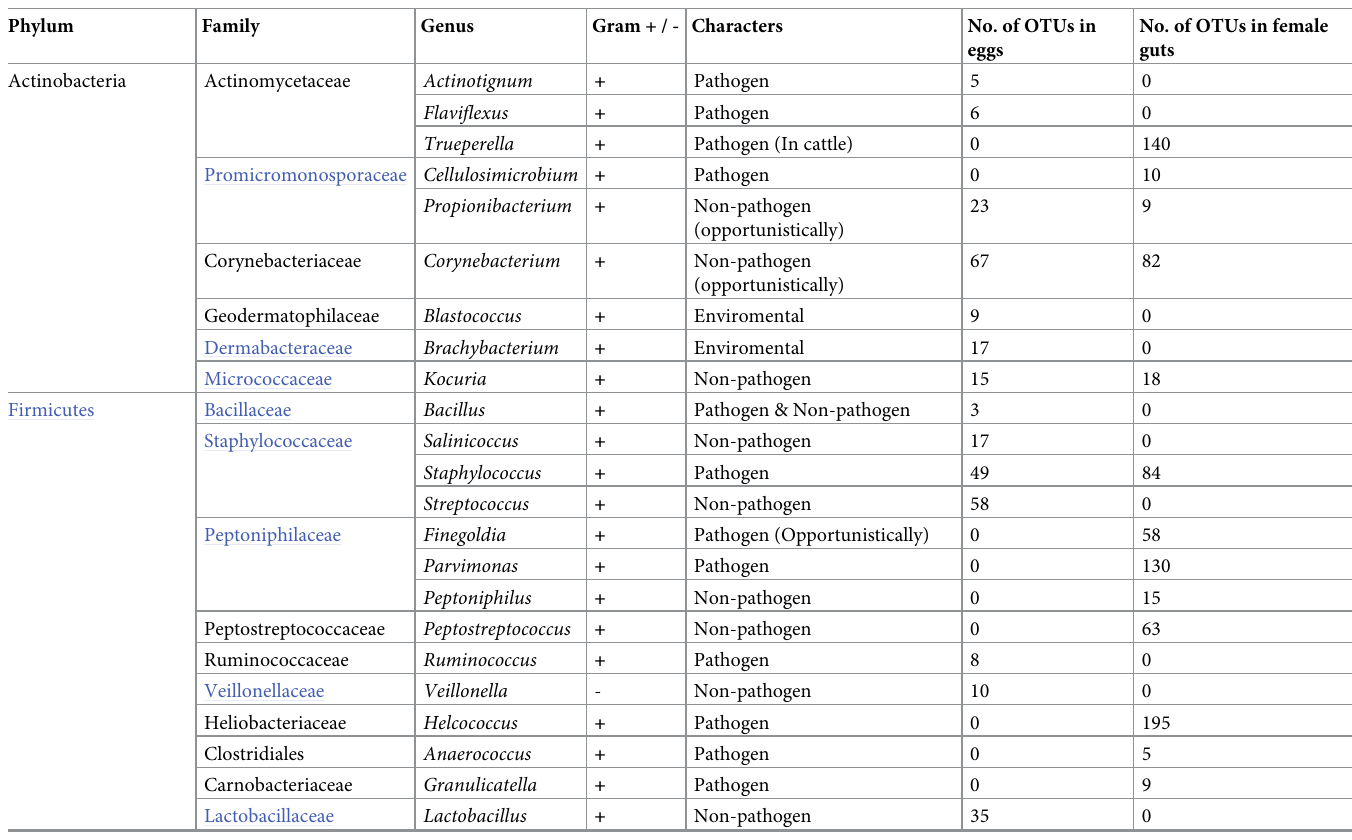
Table 3. Taxonomic, characters, and the number of operational taxonomic units (OTUs) in H . anatolicum eggs and female guts revealed by NGS. Phylum Family Genus Gram + / - Characters No. of OTUs in